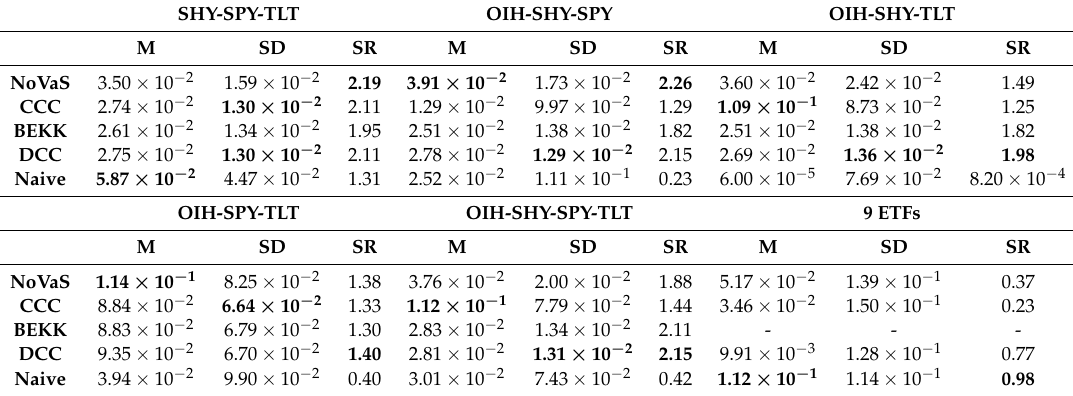
Table 10. Mean (M), standard deviation (SD) and Sharpe ratio (SR) of portfolio returns with monthly rebalancing and with weights computed on 2/3 of available observations.